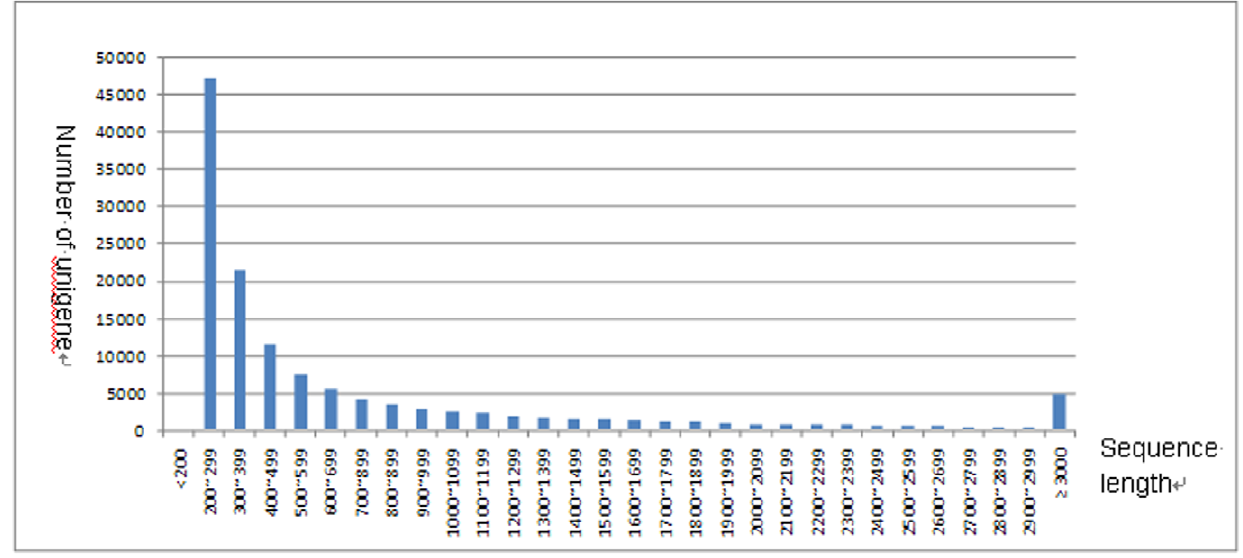
Figure 1. Histogram of the sequence length distribution of the significant matches. The x-axis indicates sequence sizes from 200 nt to $ 3000 nt. The y-axis indicates the number of unigenes for every given sequence length. The results of the sequence–length matches (with a cut- off E-value of 1.0E 2 5) in the NCBI nr databases are greater among the longer assembled sequences. doi:10.1371/journal.pone.0055496.g001 nucleotide mismatch. The clean tags were designated as unambig- to RPKM (Reads per kilobase transcriptome per million mapped uous clean tags. For gene expression analysis, the number of reads). unambiguouscleantagsforeachgenewascalculatedandnormalized